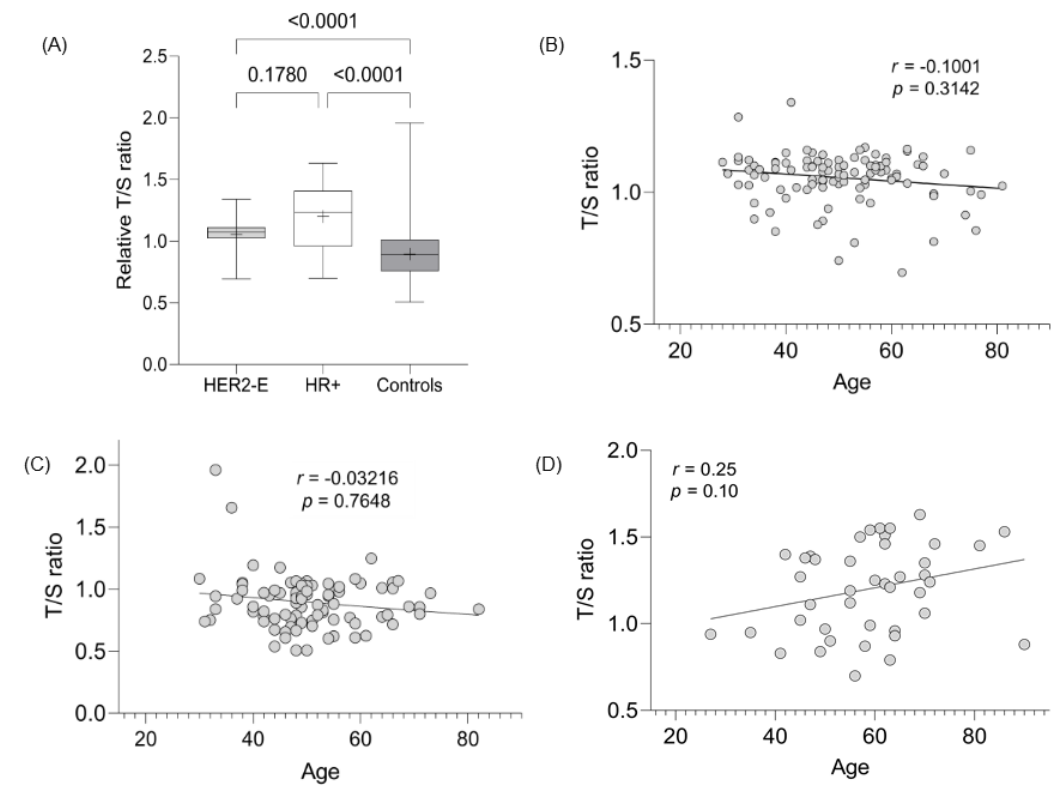
Figure 2. Evaluation of TL between groups and its correlation with age. ( A ) Significance TL assess- ment between breast and control tumor subtypes. ( B ) Correlation between age and LTL from HER2-E cases. ( C ) Correlation between age and LTL from controls. ( D ) Correlation between age and LTL from HR+ cases.